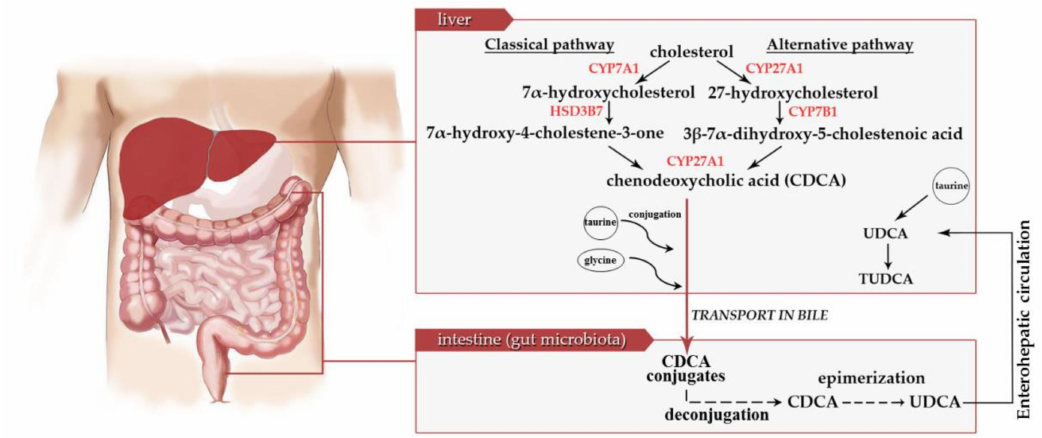
Figure 2. Biosynthesis of tauroursodeoxycholic acid. Detailed description in the